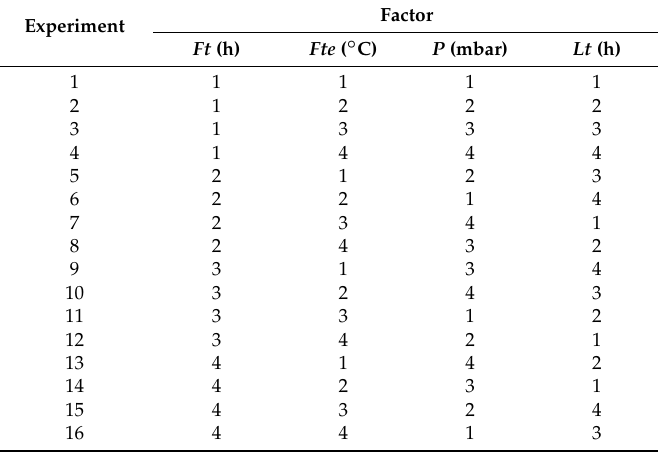
Table 2. L 16 4 4 orthogonal experimental design